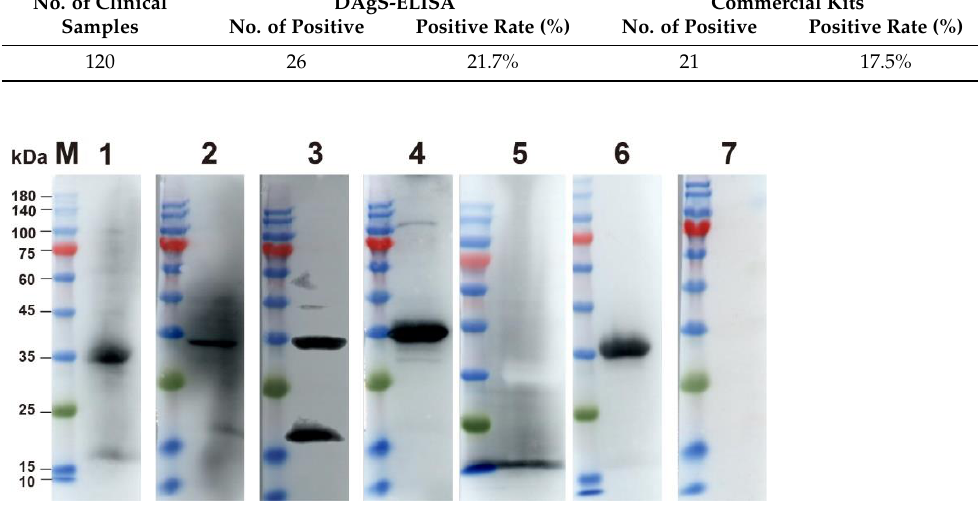
Figure 7. Western Blot results of five clinical sera. Line M: protein markers (10 kDa – 180 kDa); lines 1 – 5: five clinical sera with controversial. The results show that serums 1 – 4 are positive, while 5 is negative; line 6: Standard positive serum; line 7: Standard negative serum.